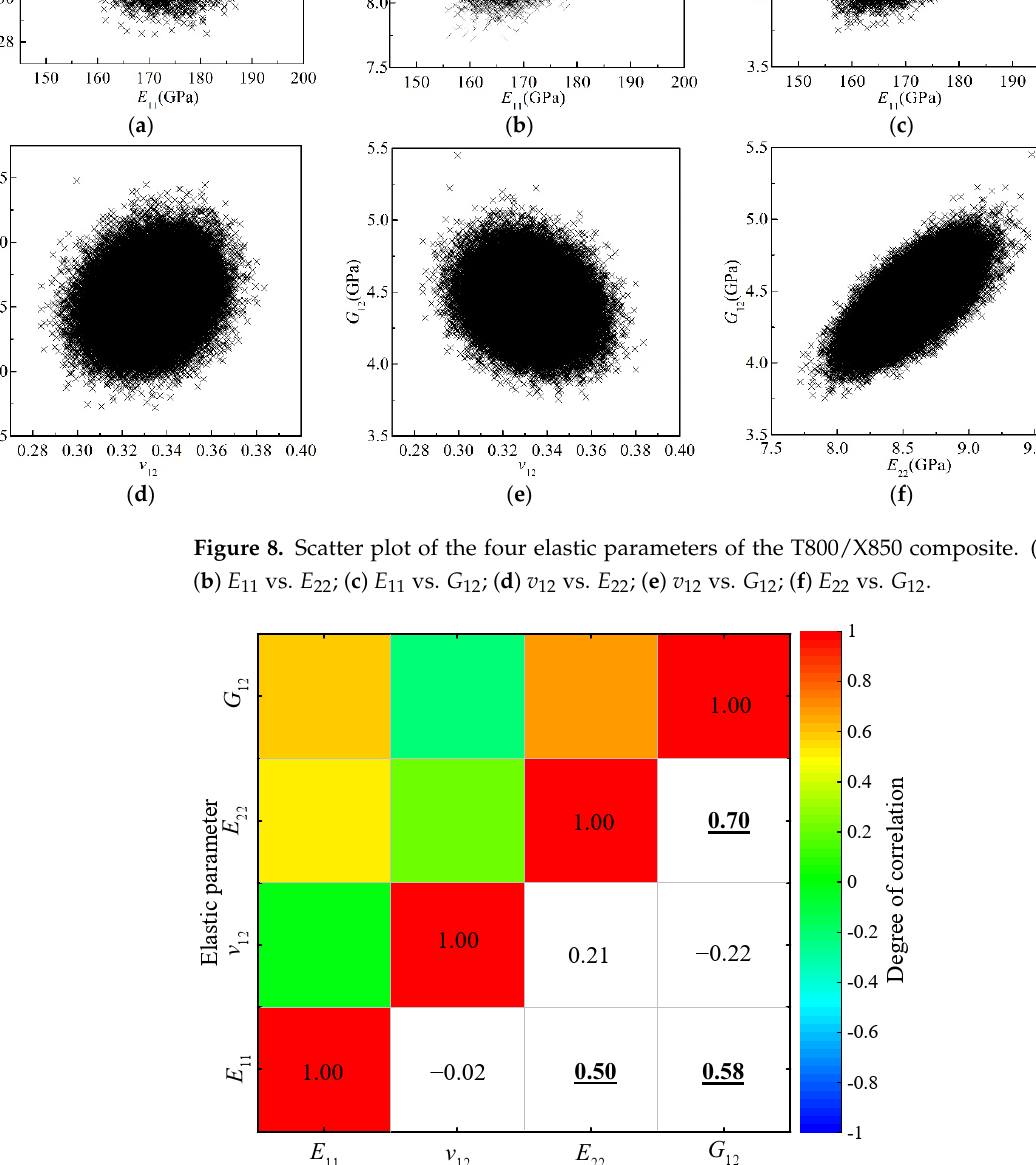
Figure 9. Correlation coefficients between the four elastic properties of the T800/X850 composite.